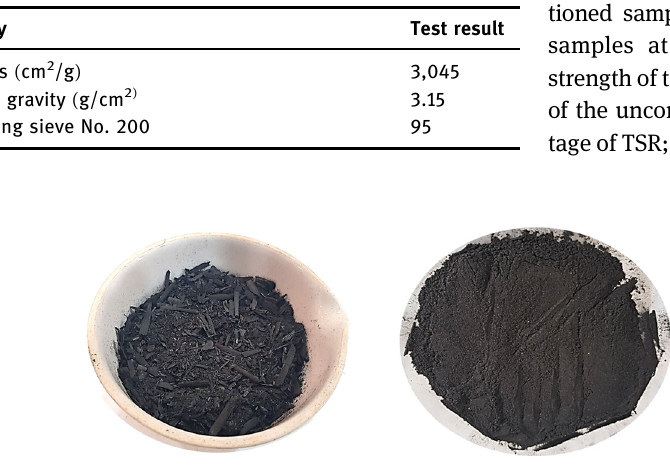
Figure 1: Production stages of